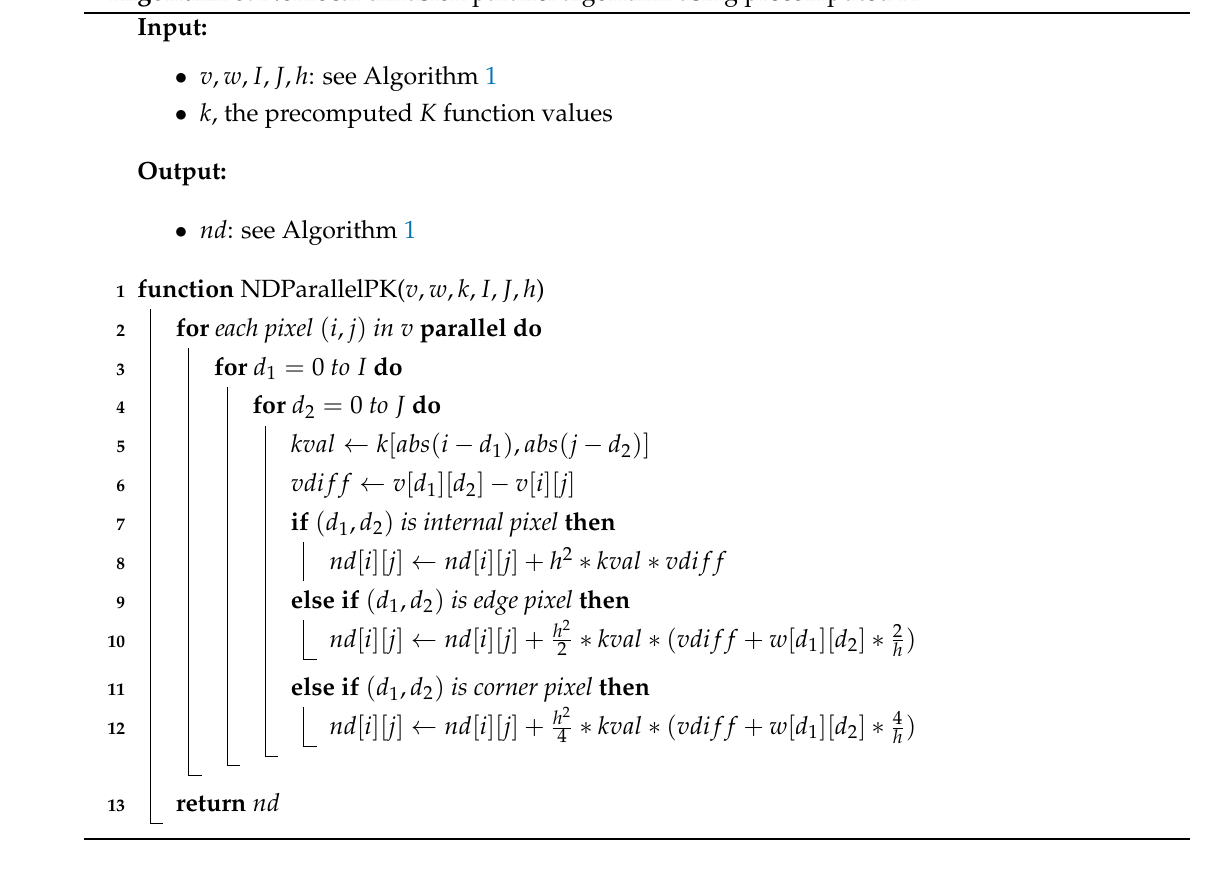
Algorithm 5: Nonlocal diffusion parallel algorithm using precomputed K